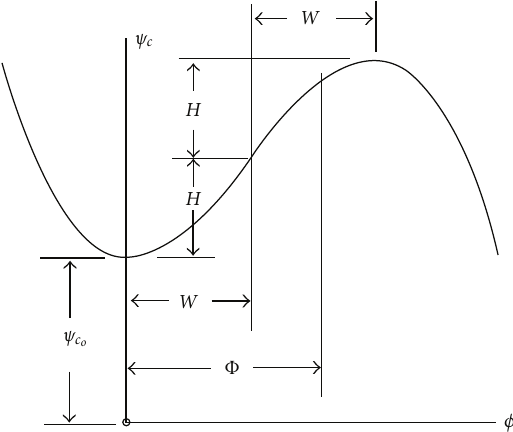
Figure 2: Cubic axisymmetric characteristic of Moore and Greitzer [14, 15].